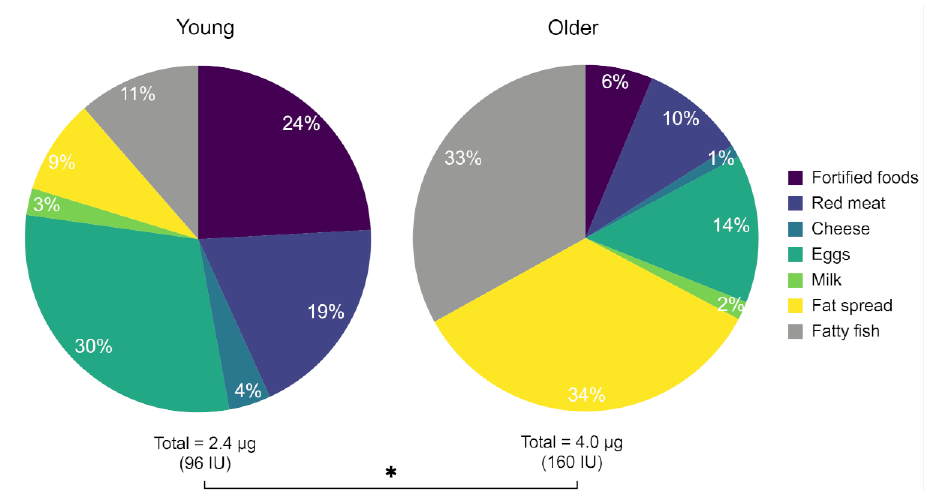
Figure 6. Average dietary vitamin D intake in µ g (and IU) per day in young and older groups of volunteers. * indicates p value of < 0.05